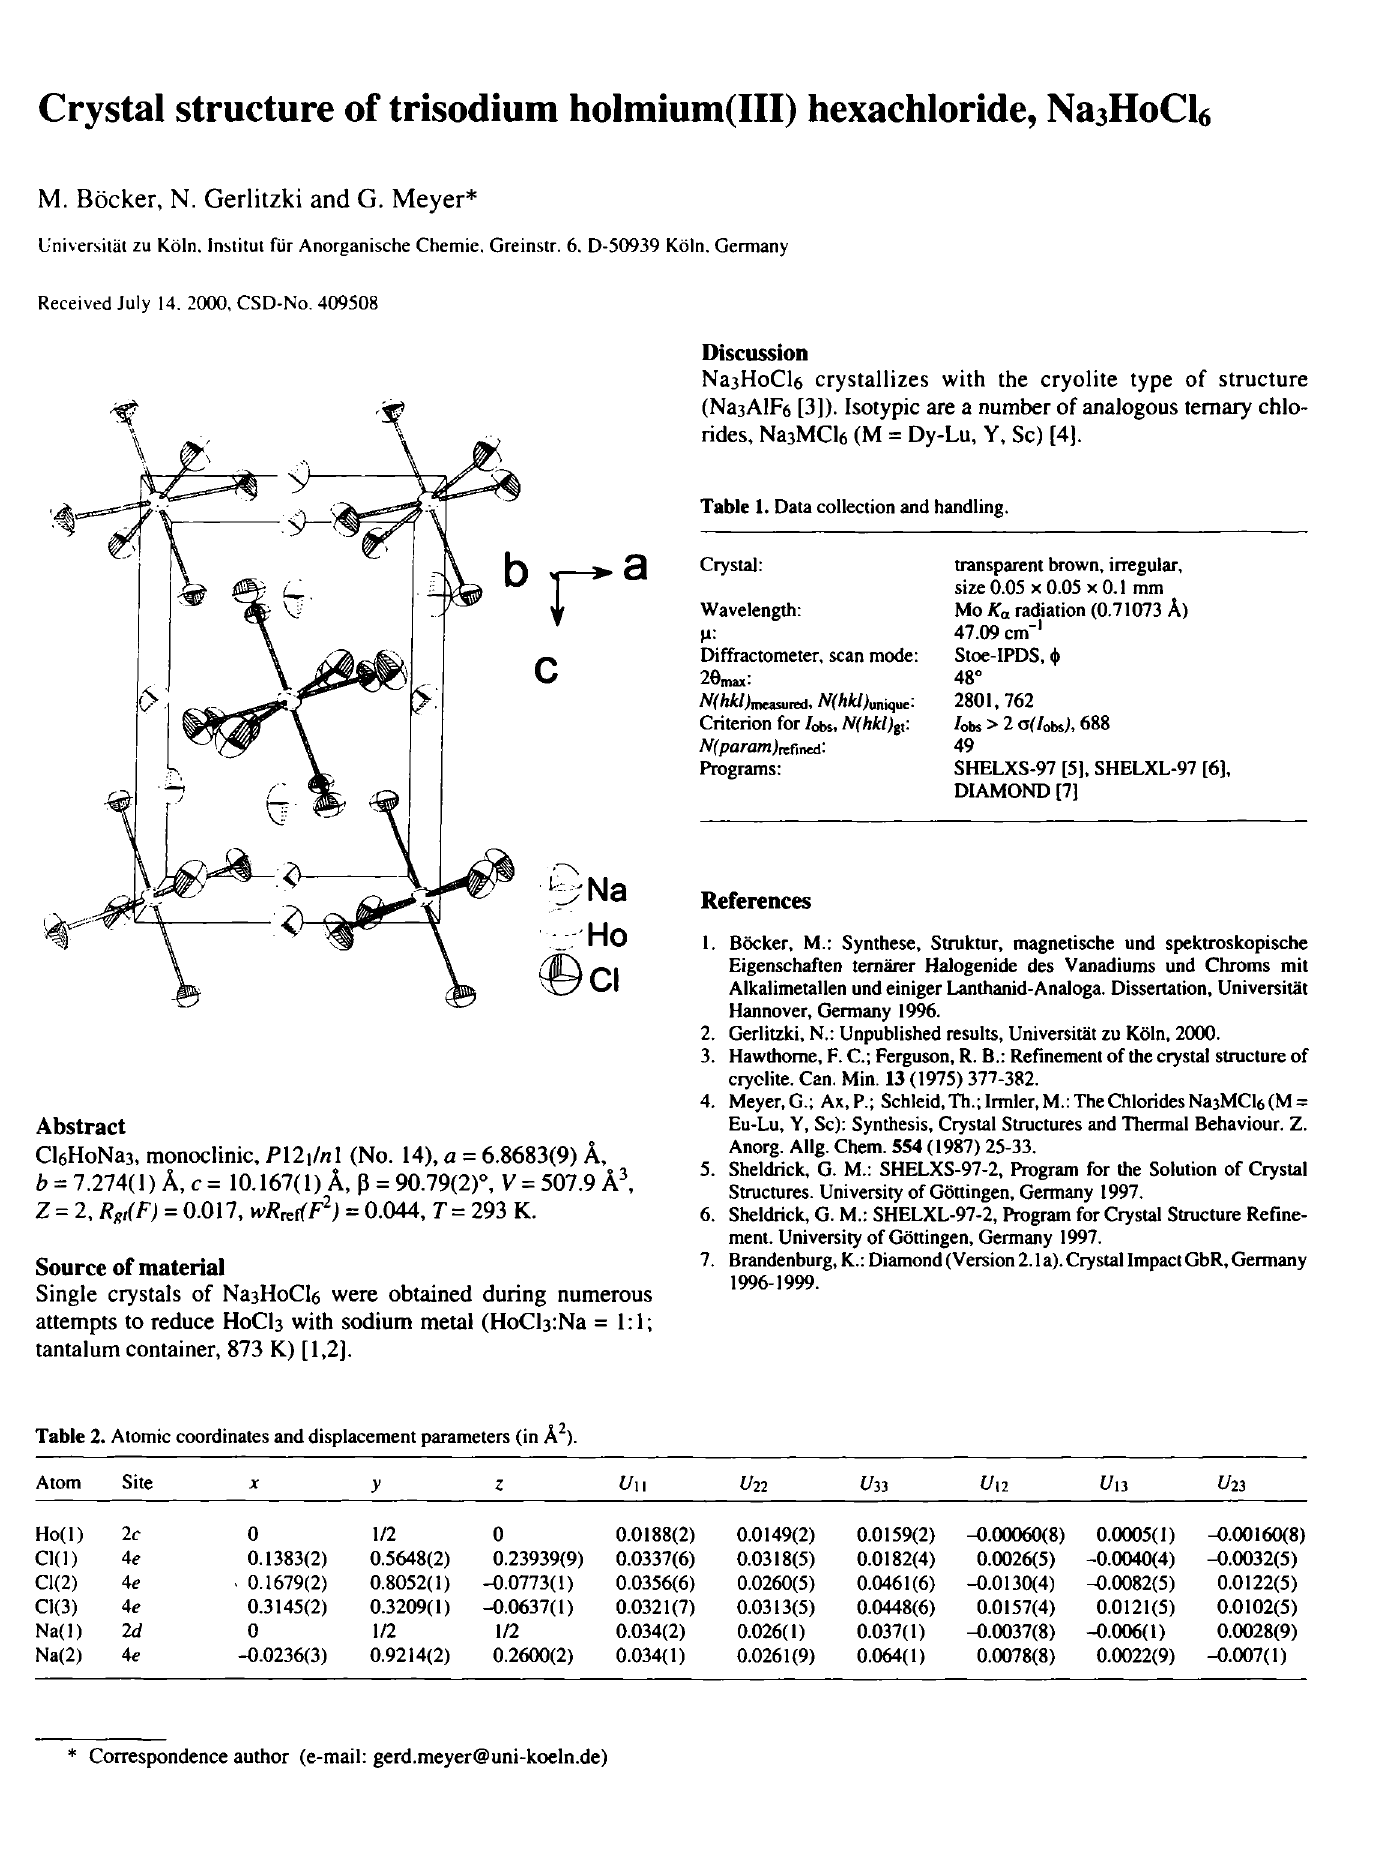
Table 2. Atomic coordinates and displacement parameters (in Ä 2